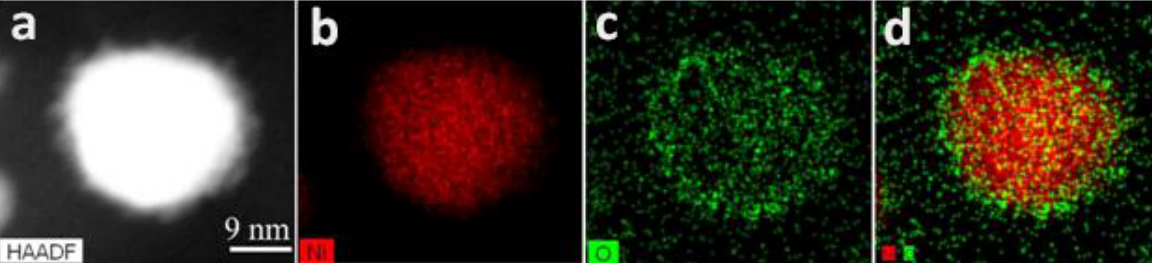
Figure 8. STEM dark-field image ( a ) and EDS maps of Ni ( b ), O ( c ), and Ni-O superposition ( d ) of a single Ni NP@PPP obtained at 280 °C by the heat-up procedure.